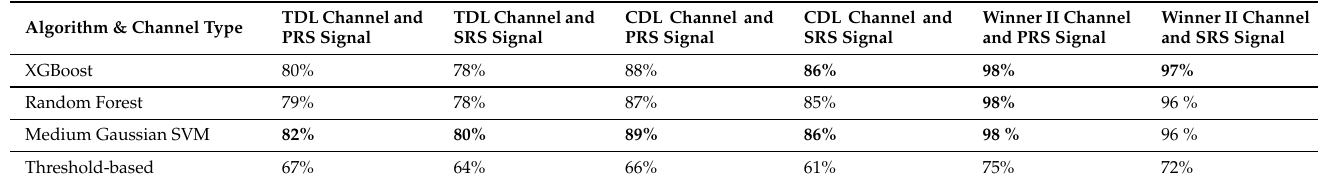
Table 5. LOS detection accuracy ([%]) with simulated data, using three ML approaches and a benchmark threshold-based approach. Bold-faced numbers show the best results per channel